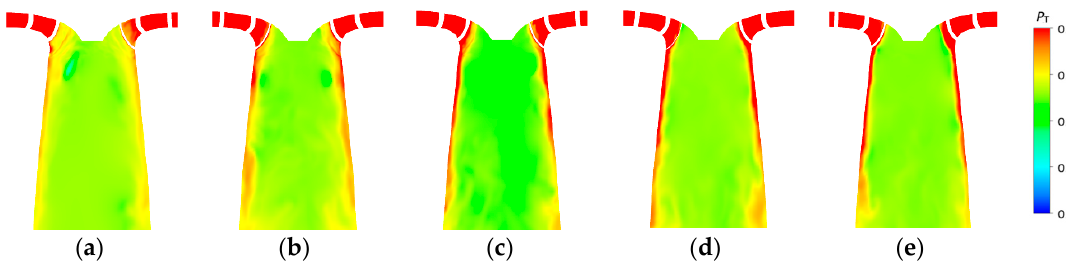
Figure 10. Distribution of total pressure P T for 6° GVO at some typical instants; ( a ) t = 0.18 s; ( b ) t = 1.08 s; ( c ) t = 2.52 s; ( d ) t = 3.18 s; ( e ) t = 3.48 s.